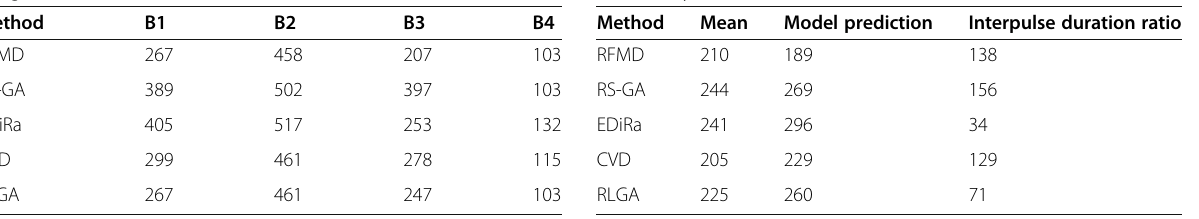
Table 5 Number of discrete intervals in each attribute of the